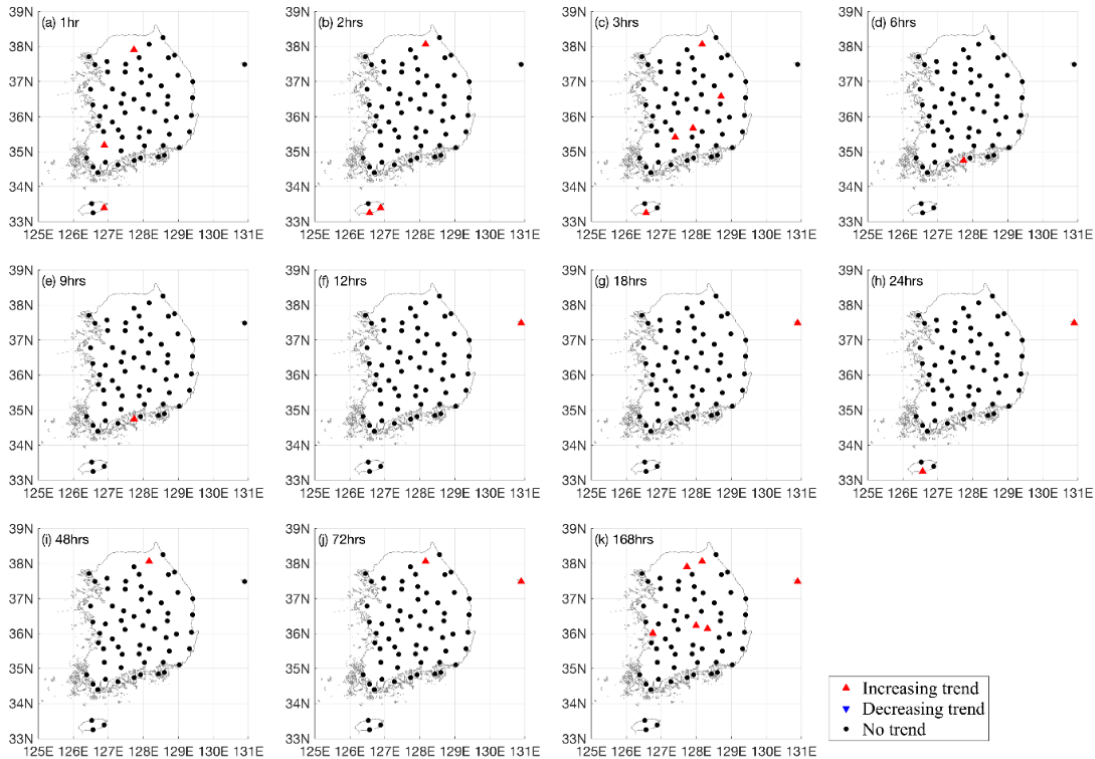
Figure 4. The block bootstrap-based Mann-Kendall (BBS-MK) test results of AM series for all employed durations at 5% significant level.